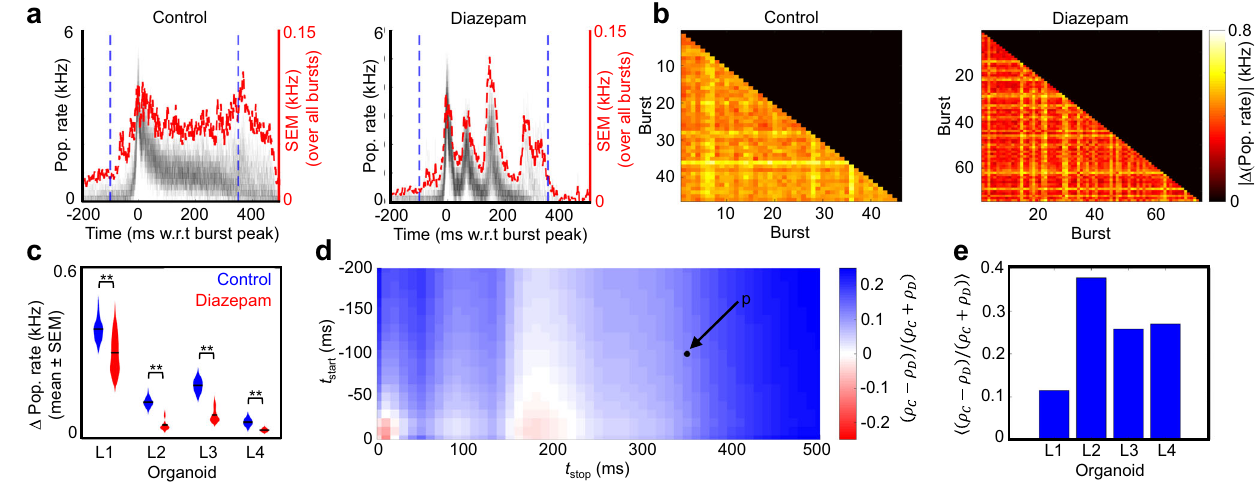
Fig. 4 | Diazepam-induced changes in population-level dynamics in a human brain organoid slice. a The population averaged fi ring rate (pop. rate) for the control and diazepam recordings (organoid L1 here) calculated from single-unit activityaveragedovera5mswindow.Thepopulationrateforeachburstisplotted individually, centered by the peak in multi-unit activity (MUA). The standard error of the mean (SEM) calculated over all bursts is plotted in red. b Population rate average differences are shown across all individual burst pairs for the control and diazepam(50 μ M)recordingsfromthesameorganoid.Theaveragepopulationrate difference is computed over a time window of − 100ms to +350ms relative to the MUA peak (blue dotted line in a ). The color bar scale is the same for control and diazepam. See Supplementary Fig. 10 for visualization from a separate organoid. c Average population vector differences taken over all individual burst pairs per recording for control and diazepam (50 µ M) conditions. The population vector